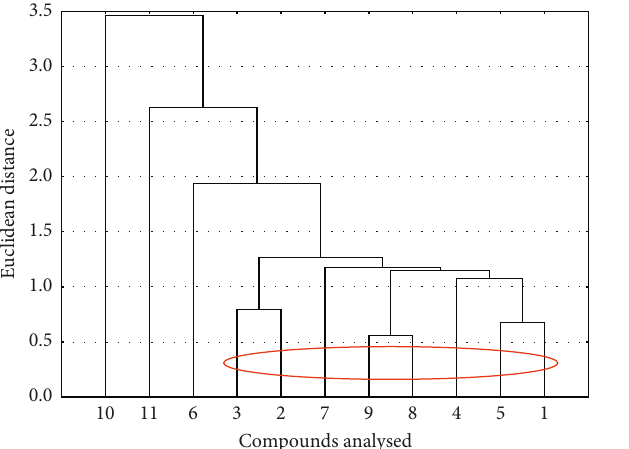
Figure 3: Similarity analysis for compounds investigated based on their values of physicochemical properties.